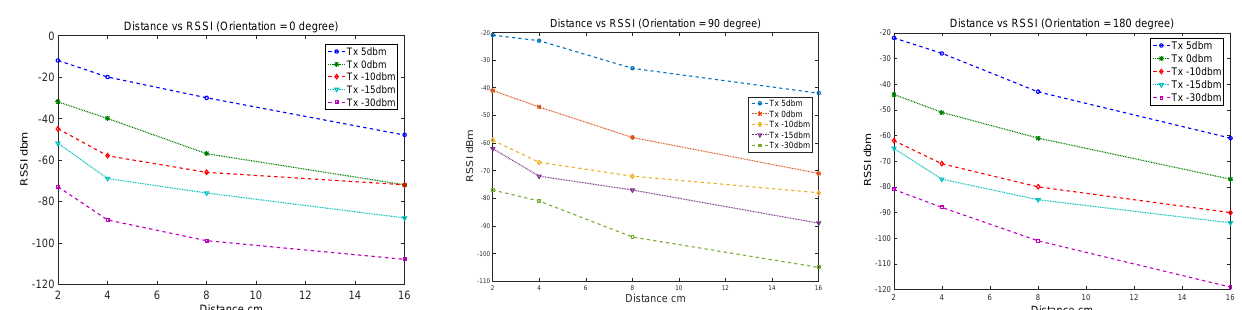
Figure 8: RSSI vs Distance at 90 degree antenna orientation